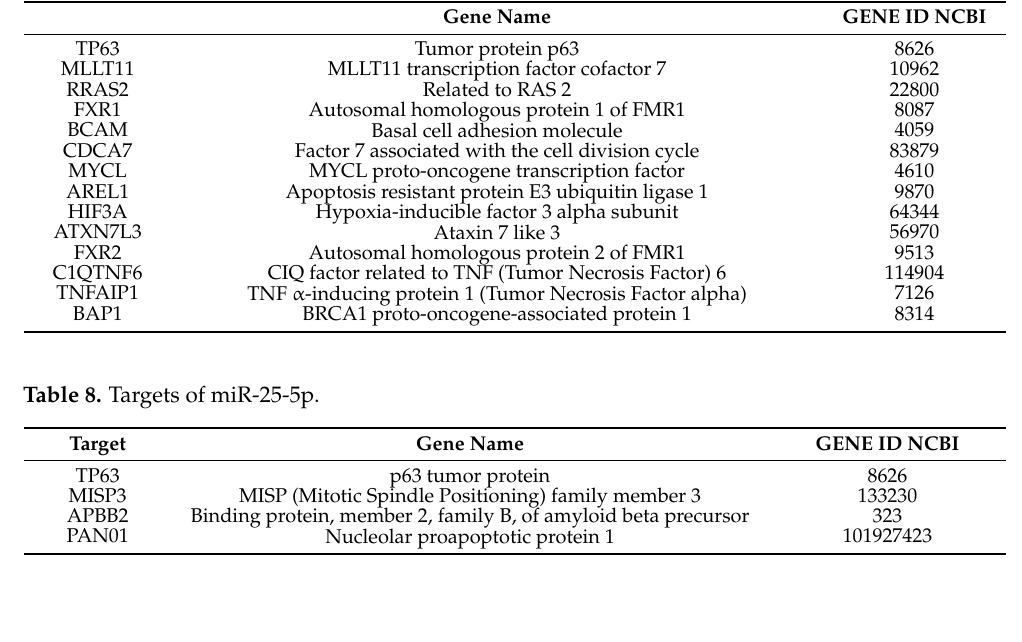
Table 7. Targets of miR-4721.